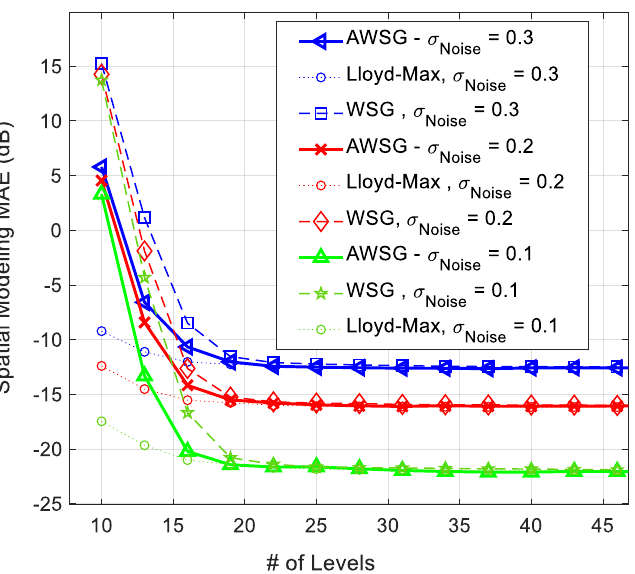
Figure 4. Comparison between the spatial modeling MAE of AWSG and WSG in the presence of different noise strengths σ N , during convergence process of the